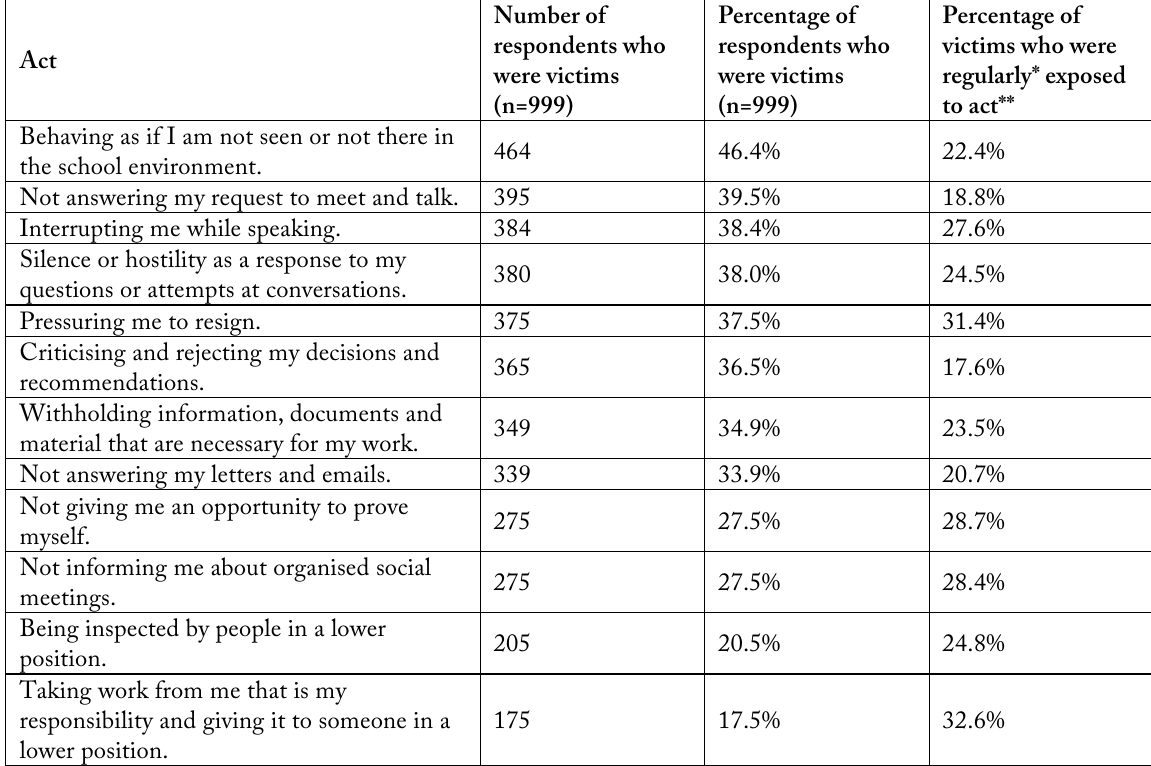
Table 3: Respondents who experienced behaviour that causes isolation